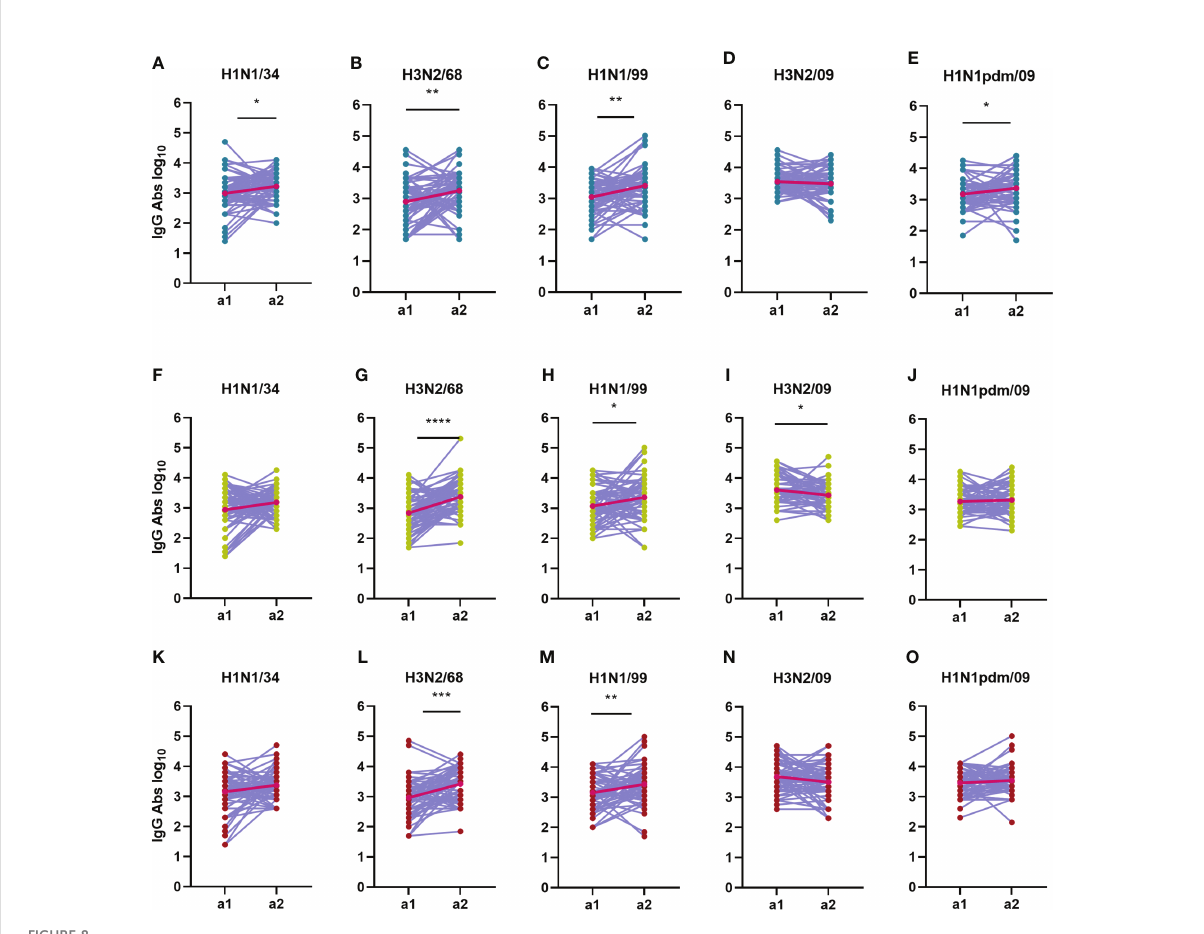
FIGURE 8 Change in total IgG antibody titers over time during an interval of 5 years. The IgG antibody titers from 180 subjects during a1 are compared with the IgG titers from a2 for each virus strain ( A, F, K : H1N1/34; B, G, L : H3N2/68; C, H, M : H1N1/99; D, I, N : H3N2/09; E, J, O : H1N1pdm/09) and age group ( A – E : adolescents; F – J : adults; K – O : elderly). Titers of a given individual in a1 and a2 are connected by a line. Geometric means for the two assessments are depicted in the graphs as bright red dots connected by a red line. Data were compared using Wilcoxon